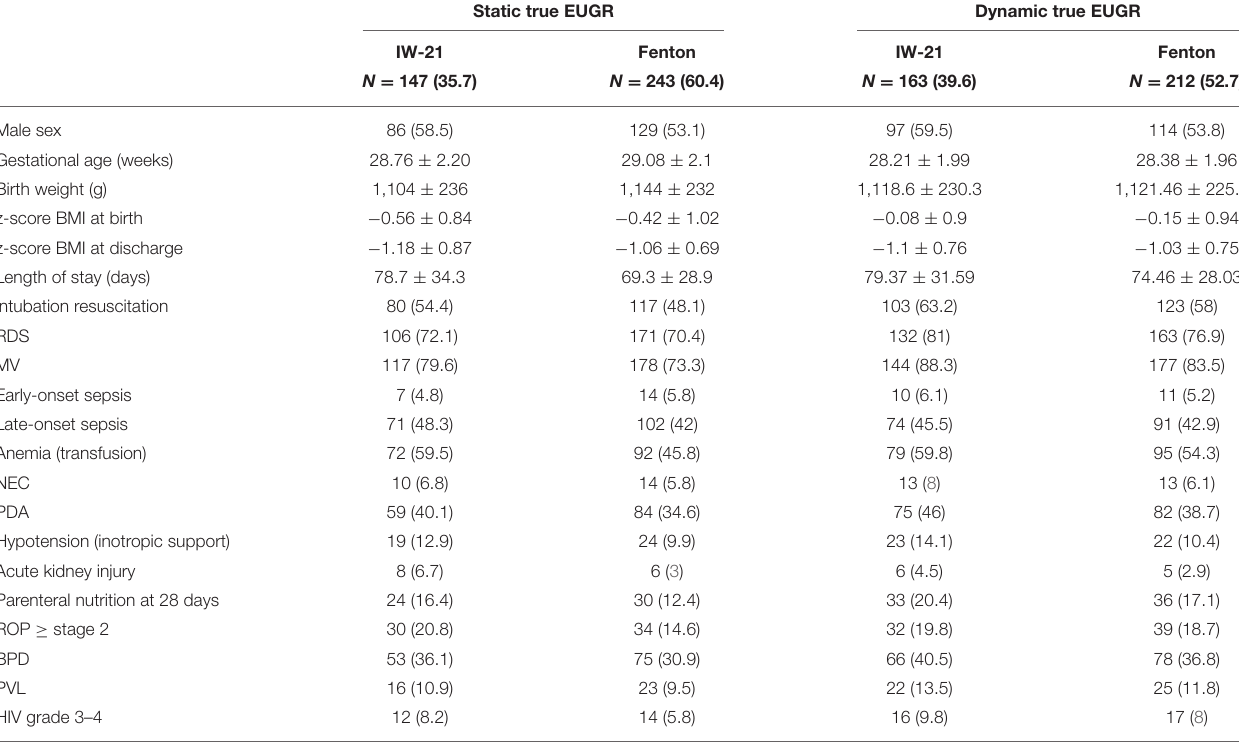
TABLE 6 | Static and dynamic “true * EUGR” compared with “true * non-EUGR” and their comorbidities for INTERGROWTH-21st and Fenton 2013. Static true